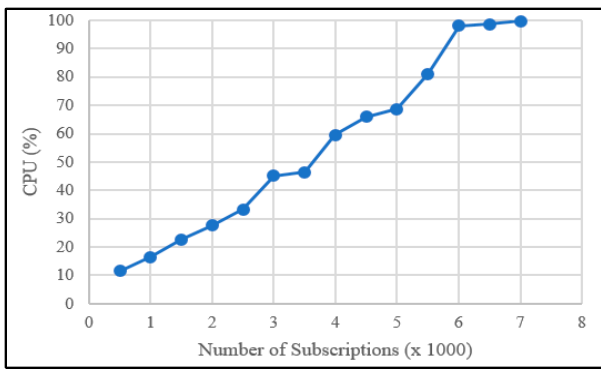
Figure 32. CPU utilisation vs. number of subscriptions.